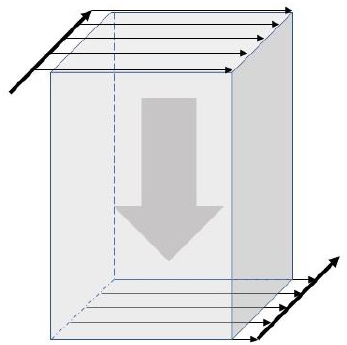
Figure 1. Schematic diagram showing flow channels (indicated by arrows) in a z 2 cuboid packed-bed device.